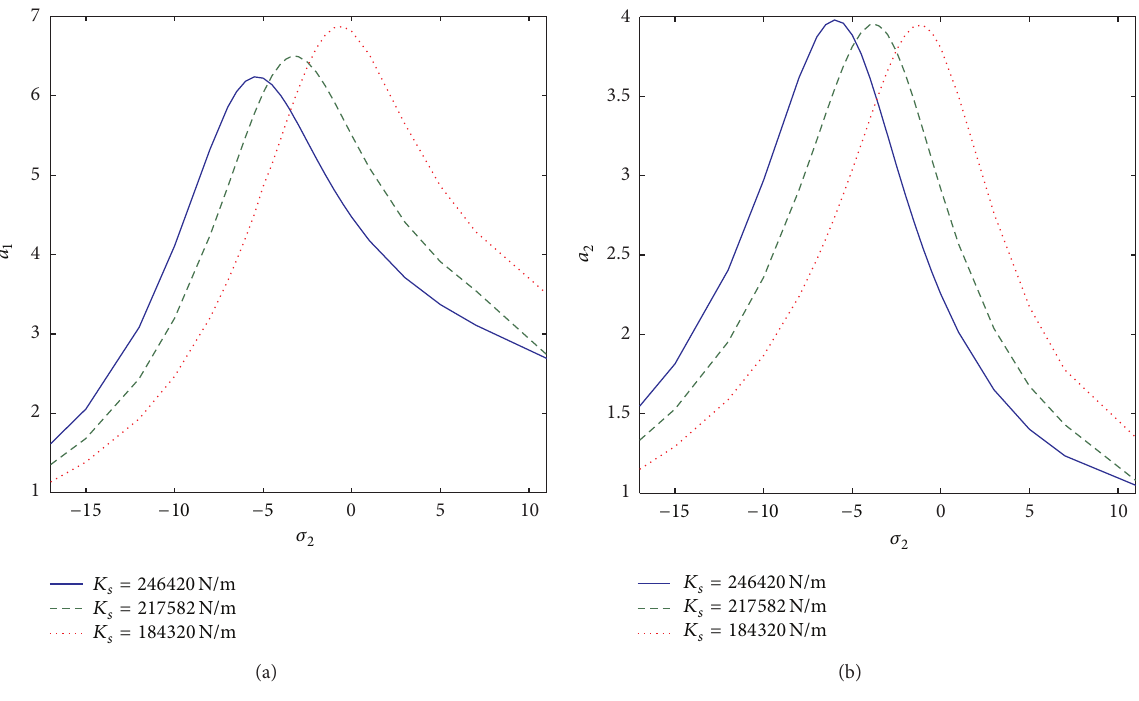
Figure 9: The influence of zero stiffness damper’s